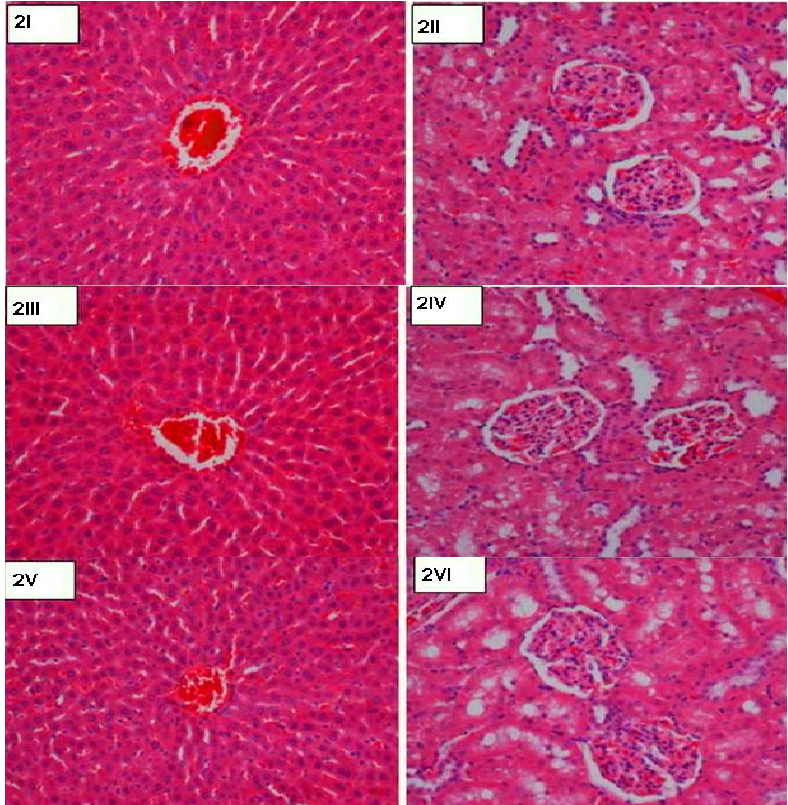
Figure 2. Histological sections of liver and kidney in acute toxicity test. ( 2I and 2II ) Rats treated with 5 mL/Kg vehicle (CMC); ( 2III and 2IV ) Rats treated with 1 g/Kg (5 mL/Kg) CuLBS; ( 2V and 2VI ) Rats treated with 2 g/Kg (5 mL/Kg) CuLBS. There is no significant differences in morphological structures of liver and kidney between treated and control groups (H & E stain 20×).